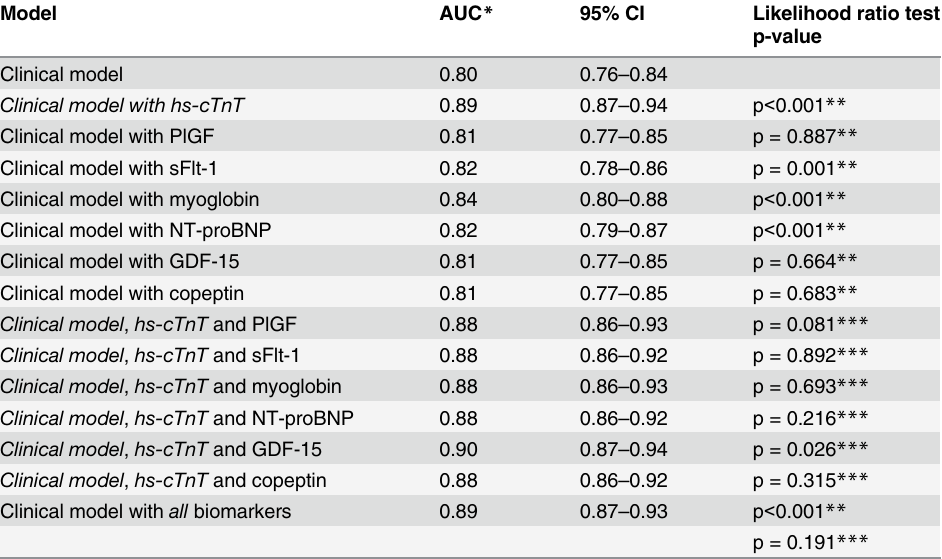
Table 6. Multivariable analysis including all patients (n = 453).